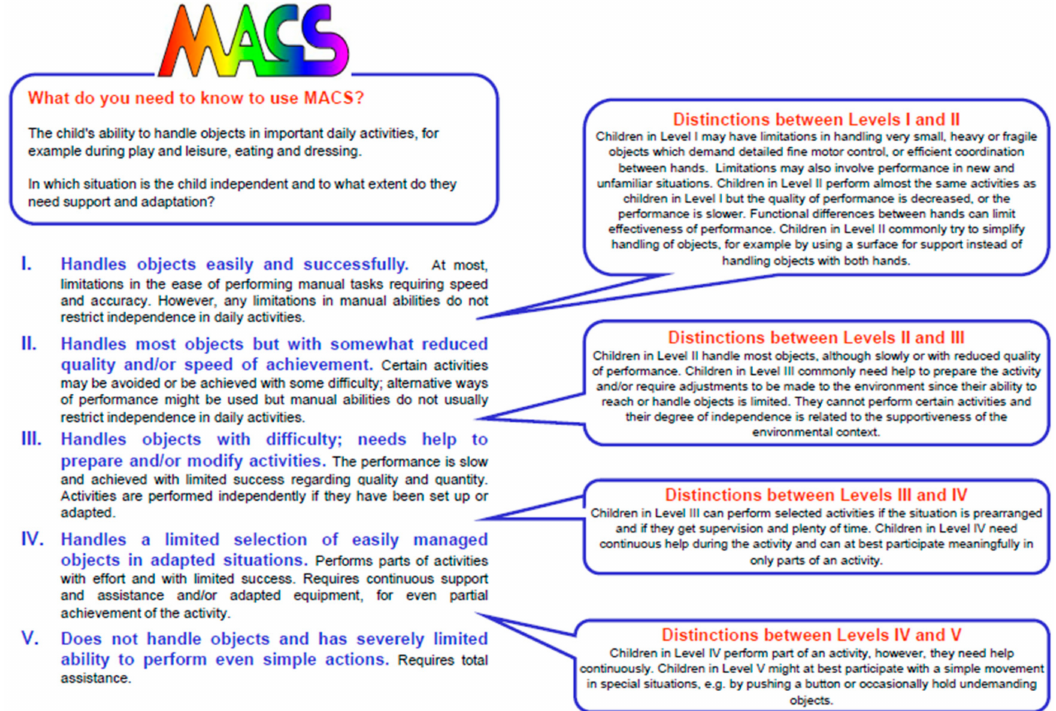
Figure 2. Summary of the five Manual Ability Classification System (MACS) levels. Reproduced with permission